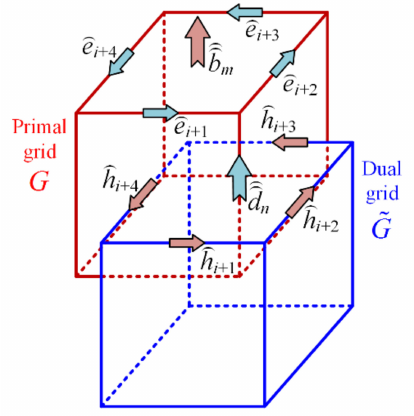
Figure 3. Allocation of electric and magnetic components in the dual grid cell-complex of finite integration theory